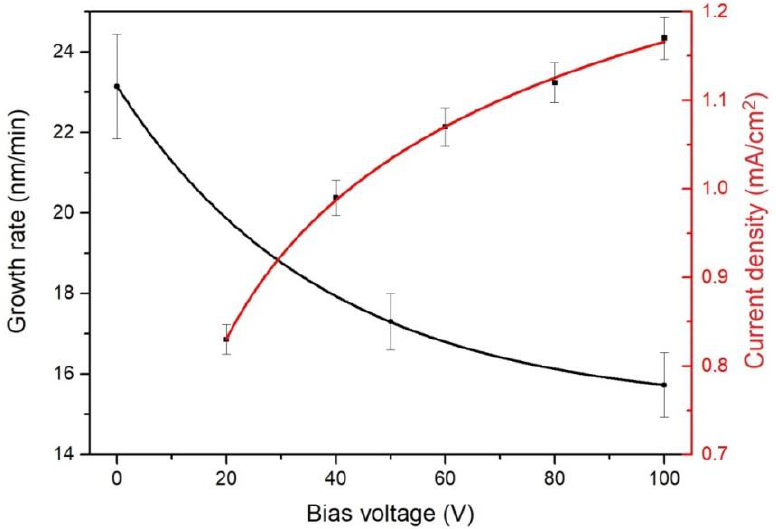
Figure 4. Dependences of deposition rate and substrate current density on the bias voltage. Table 2. Mechanical and tribological properties of the TiAlN coatings deposited by the Al magnetron at 30 W of power.